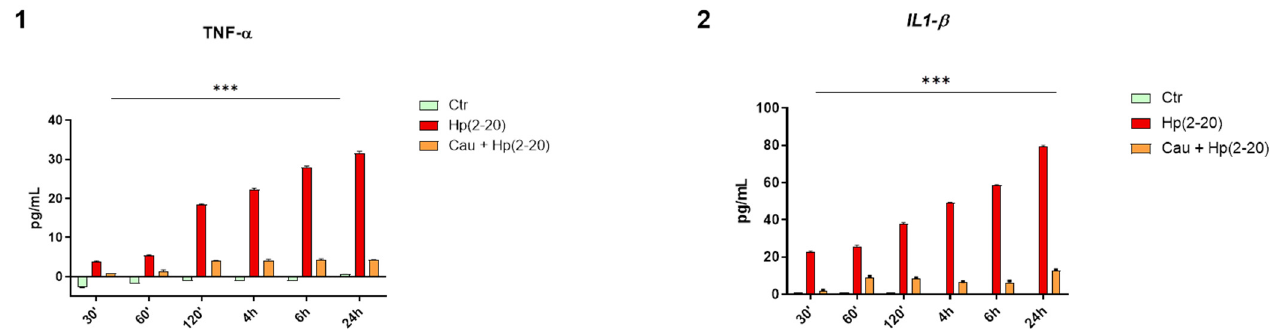
Figure 4. Cau prevents AGS-mediated macrophages activation. Cytokines: ( 1 ) TNF- α and ( 2 ) IL-1 β were measured by performing ELISA in macrophages culture medium, collected at different times. Results are expressed as pg of cytokines secreted in mL of macrophages medium, differently treated: (1) conditioned medium of AGS cells cultured with Hp(2–20) 25 µ M for 24 h; (2) conditioned medium of AGS cells pretreated with Cau 15 µ M for 30 min and then cultured with Hp(2–20) 25 µ M for 24 h. Values were normalized to the concentration of the cytokines of the AGS conditioned medium and represent mean ± SD of at least three independent experiments, each performed in triplicate. Statistical analysis was performed by GraphPad Prisma software, using one-way ANOVA test followed by Bonferroni post hoc correction. *** p < 0.0001 (Ctr vs. Hp(2–20) and Hp(2–20) vs. Cau + Hp(2–20)).